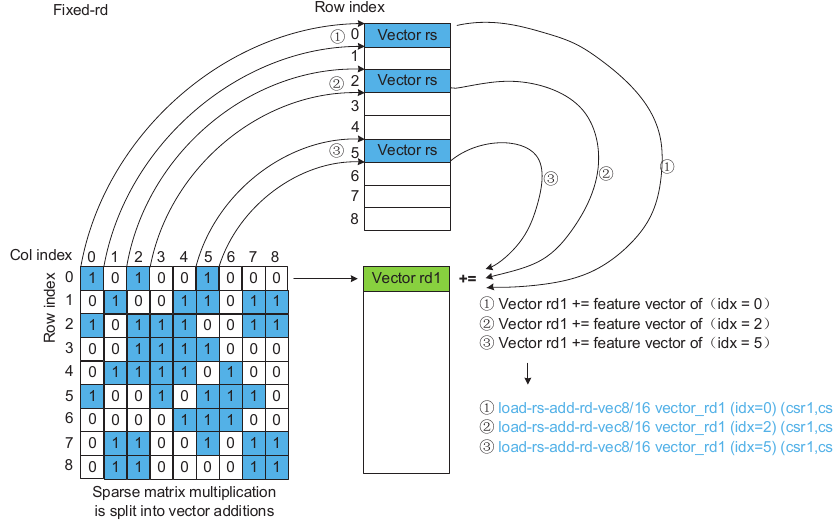
Figure 9. The computation process of fixed-rd